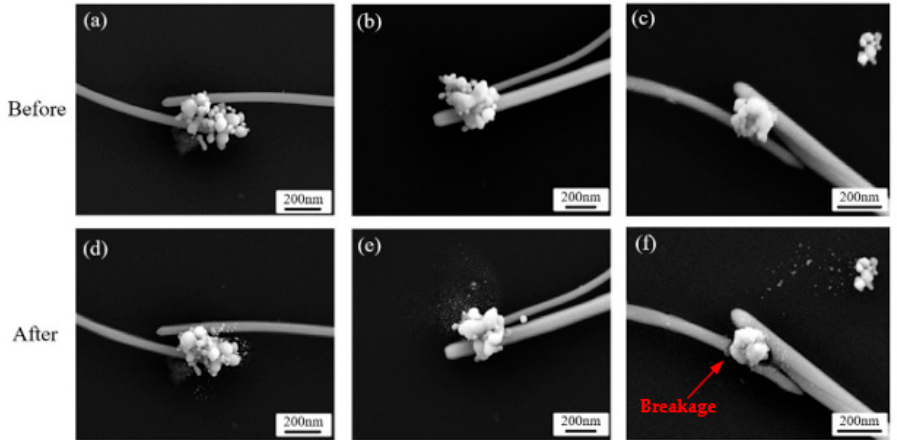
Figure 4. SEM images of the interconnection melting state at different irradiation time before and after soldering: ( a , d ) 45 s; ( b , e ) 60 s; ( c , f ) 75 s. after soldering: ( a , d ) 45 s; ( b , e ) 60 s; ( c , f ) 75